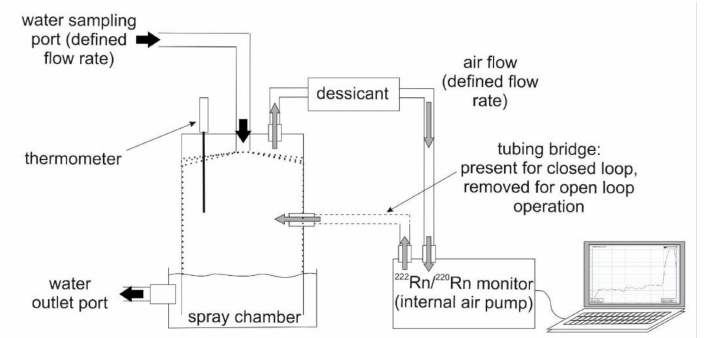
Figure 1. On-site detection setup for continuous radon / thoron measurement applying a spray chamber as extraction unit and a radon / thoron monitor with electrostatic precipitation and real-time spectral